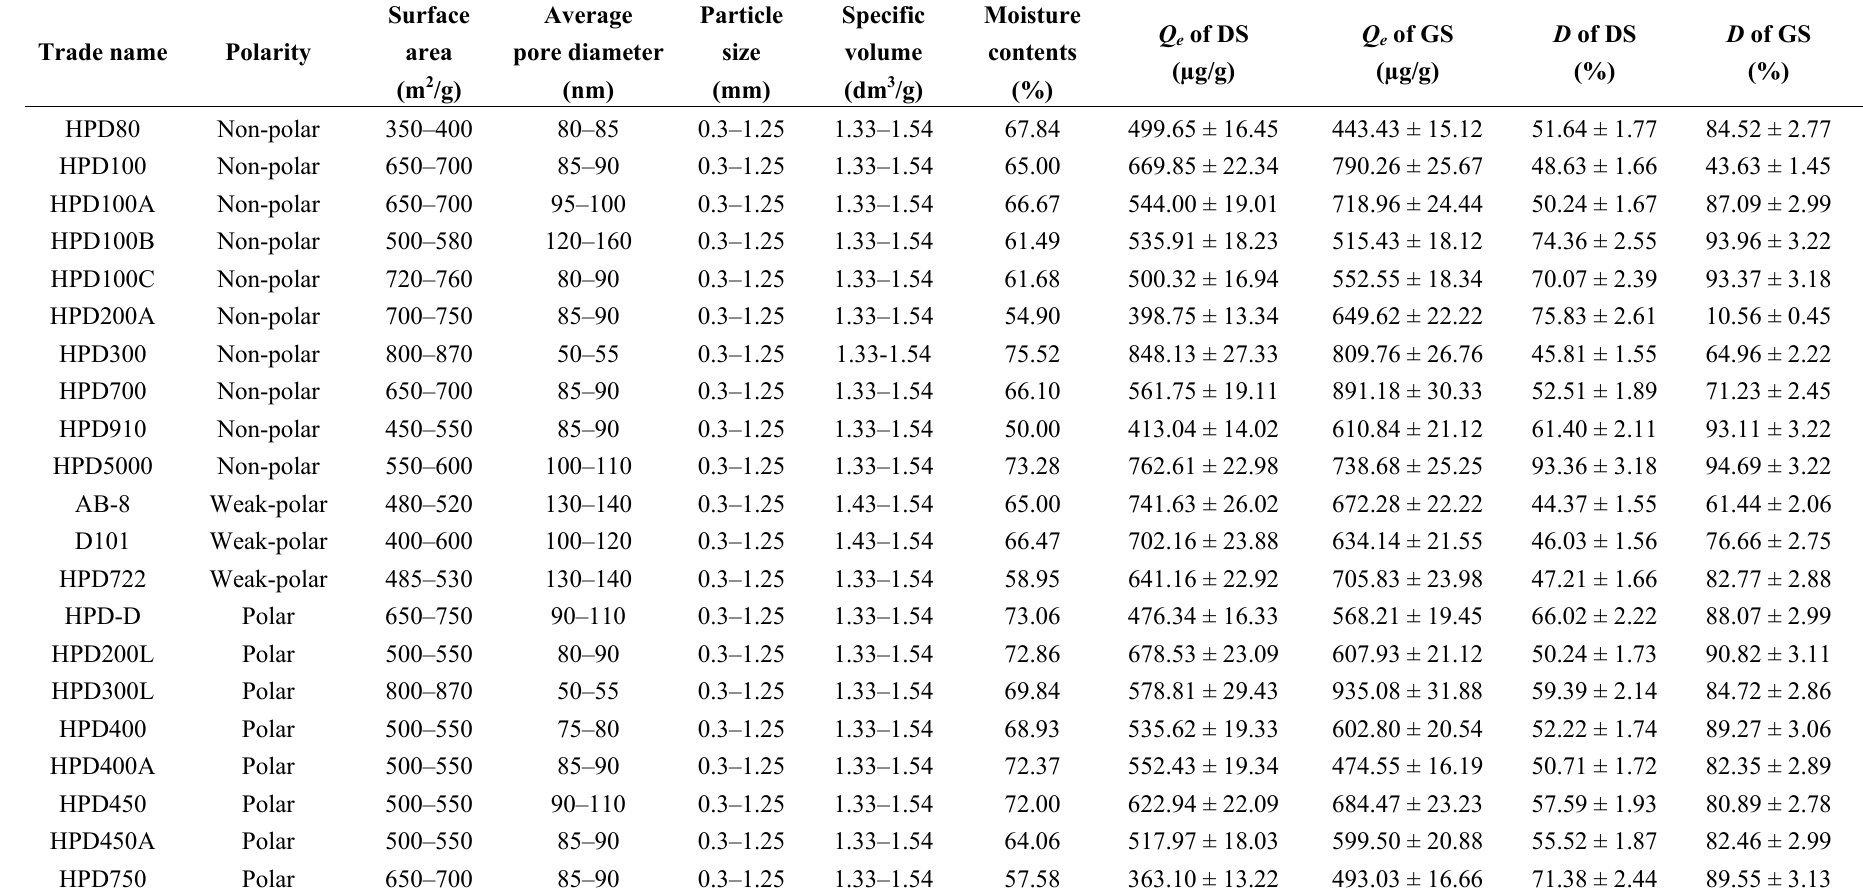
Table 1. Physical properties and absorption characteristics of the test macroporous